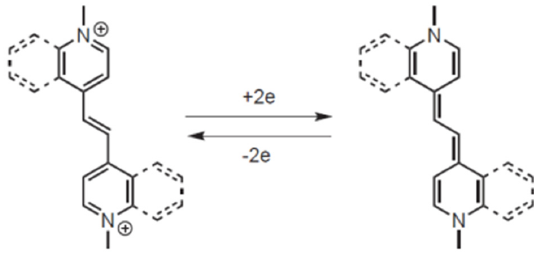
Figure 2. Schematic representation of the stabilizing effect of benzocondensation on the reduced form of diazinium ethene.